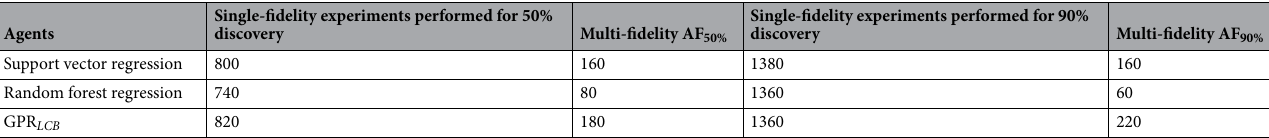
Table 1. Acceleration factor (AF) of multi-fidelity agents in simple acquisitions. The AFs are the reduction in number of experiments performed by multi-fidelity agents to achieve a certain amount of discoveries. For each row, we highlighted the agents used, the experiments performed by single-fidelity agents to achieve 50% and 80% discovery, and the acceleration factor of the multi-fidelity agents at those discoveries.